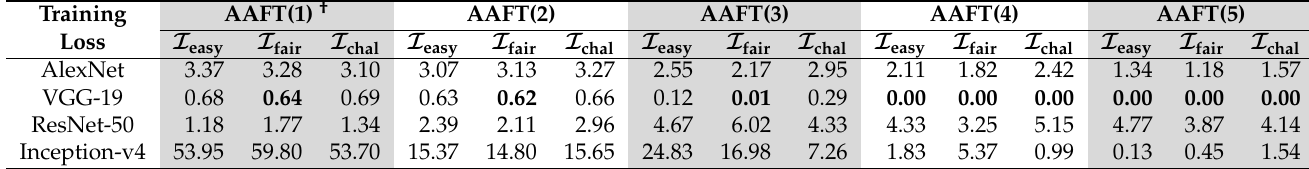
Table 6. The mean of training loss for AlexNet, VGG-19, ResNet-50, and Inception-v4.